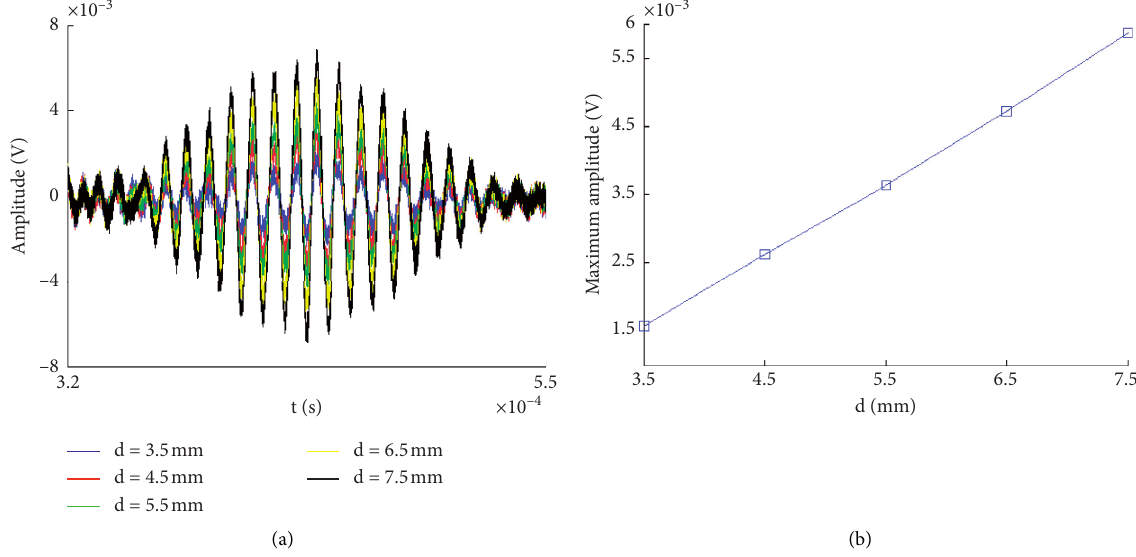
Figure 23: Parametric study of the diameter of the through-hole damages: (a) time domain waveform of the first reflected L (0, 2) mode wave packet and (b) maximum amplitude with the varied diameter of the through-hole